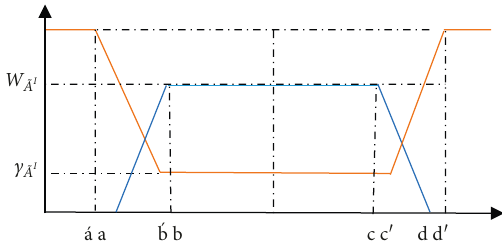
Figure 1: Trapezoidal intuitionistic fuzzy